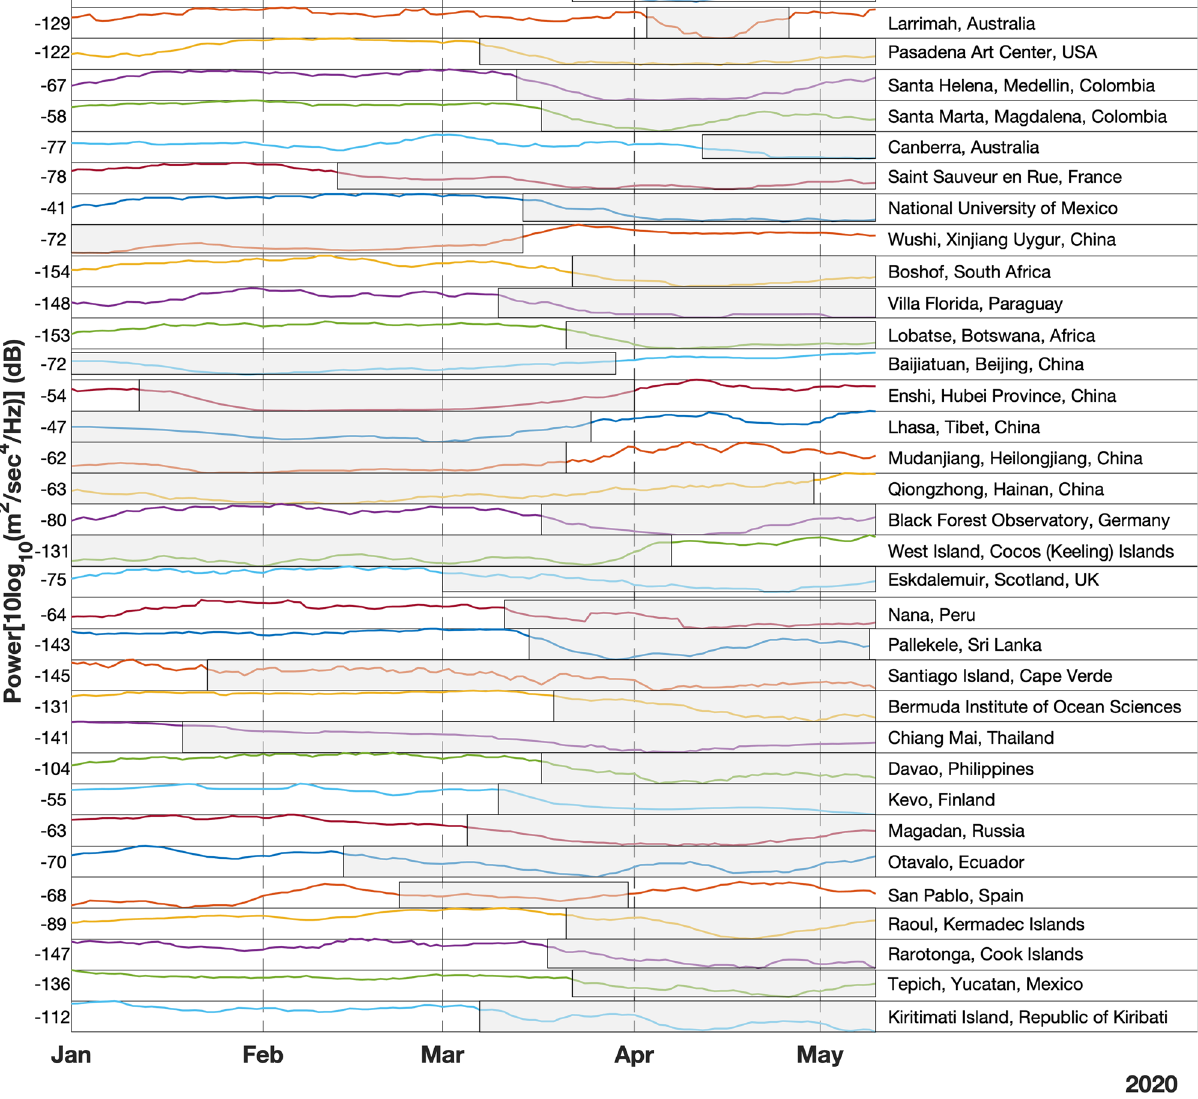
Figure 2. Seismic noise power in dB, highlighting time-period during which anthropogenic noise is lower. The text to the right of each curve represents the network and station codes. The grey shading represents mostly the lockdown periods pertinent to those sites. The value to the left of each curve is the mean of upper and lower limits of noise during the time period considered (January to early May